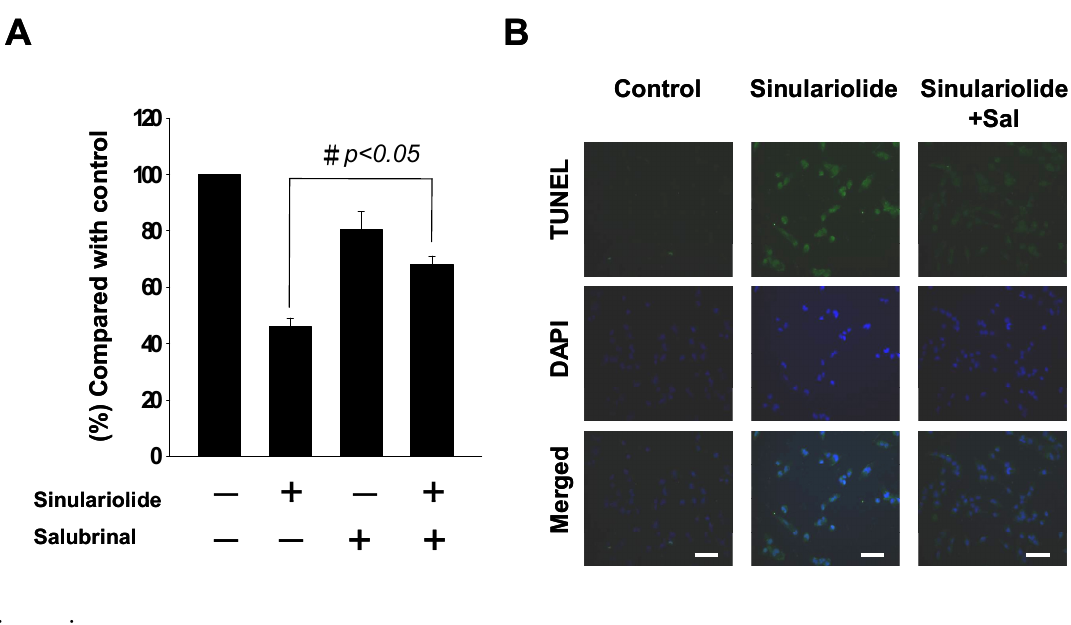
6B. After pre-treatment with salubrinal, the number of positively TUNEL-stained HA22T cells was significantly decreased. This suggested that ER stress was involved in sinulariolide-induced cell apoptosis. Figure 6. Sinulariolide induced HA22T cell apoptosis through ER stress pathways. ( A ) Salubrinal increased cell viability of the sinulariolide-treated HA22T cells. The results shown are representative of three independent experiments ( # p < 0.05, compared with the control). ( B ) The TUNEL and DAPI staining showed a decrease in sinulariolide-induced apoptotic cascade with ER stress inhibitor,